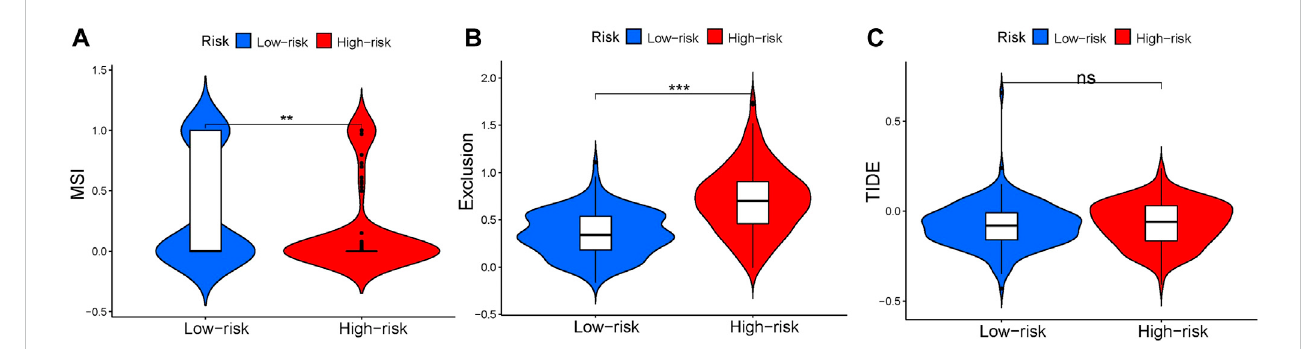
FIGURE 8 Tumor Immune Dysfunction and Exclusion between high- and low-risk groups. (A) Violin plot of MSI. (B) Violin plot of exclusion. (C) Violin plot of TIDE.